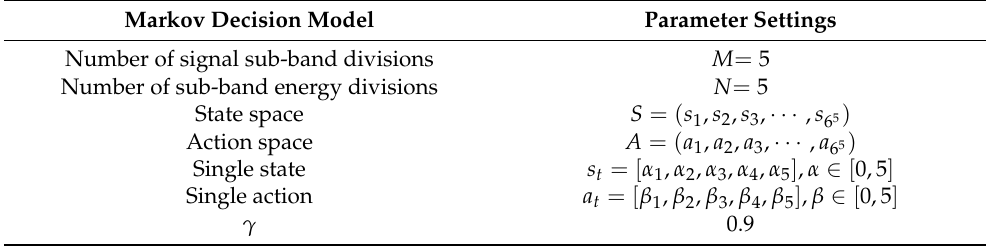
Table 2. MDP model parameter